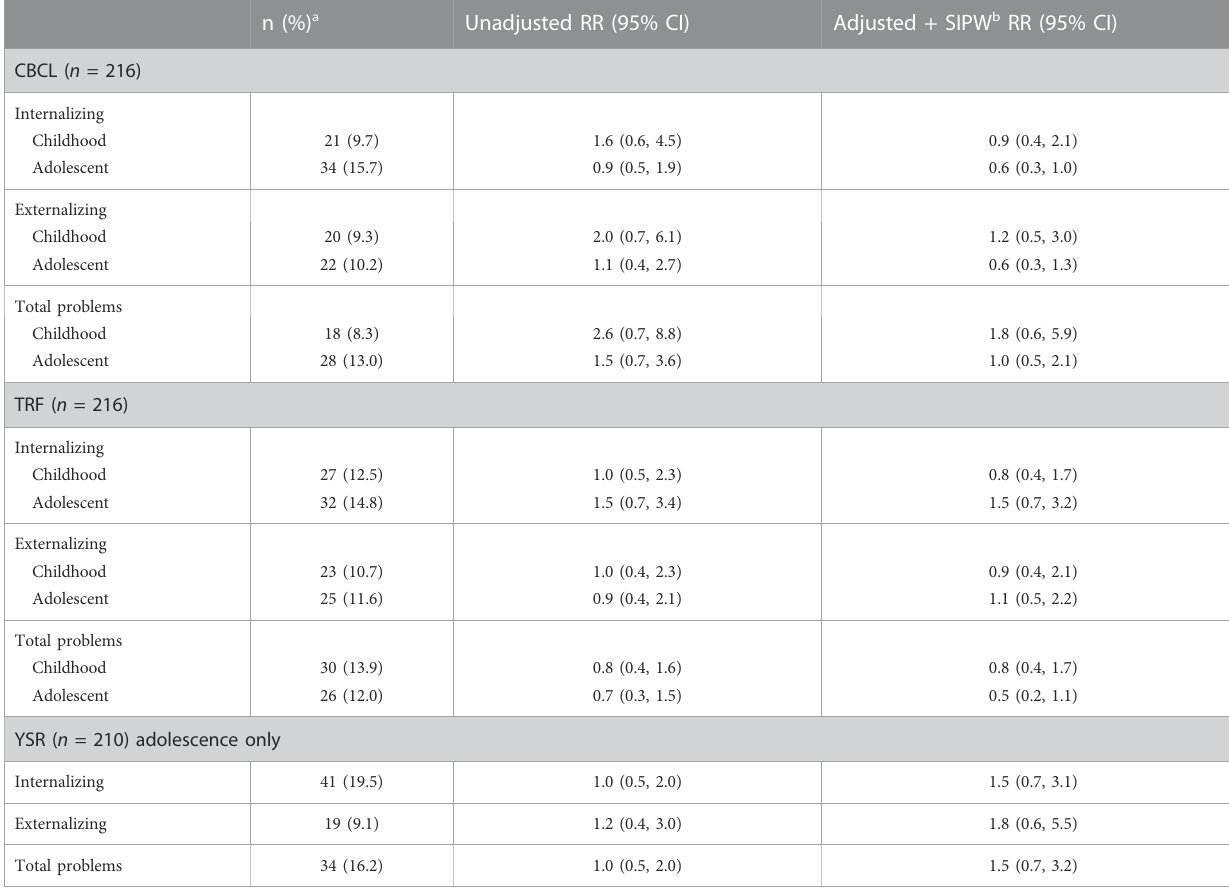
TABLE 3 Risk ratios and 95% con fi dence intervals for prenatal exposure to acetaminophen versus no exposure among children and adolescents within the borderline/clinical range for broadband scores by parent and teacher report at childhood and adolescence and youth report at